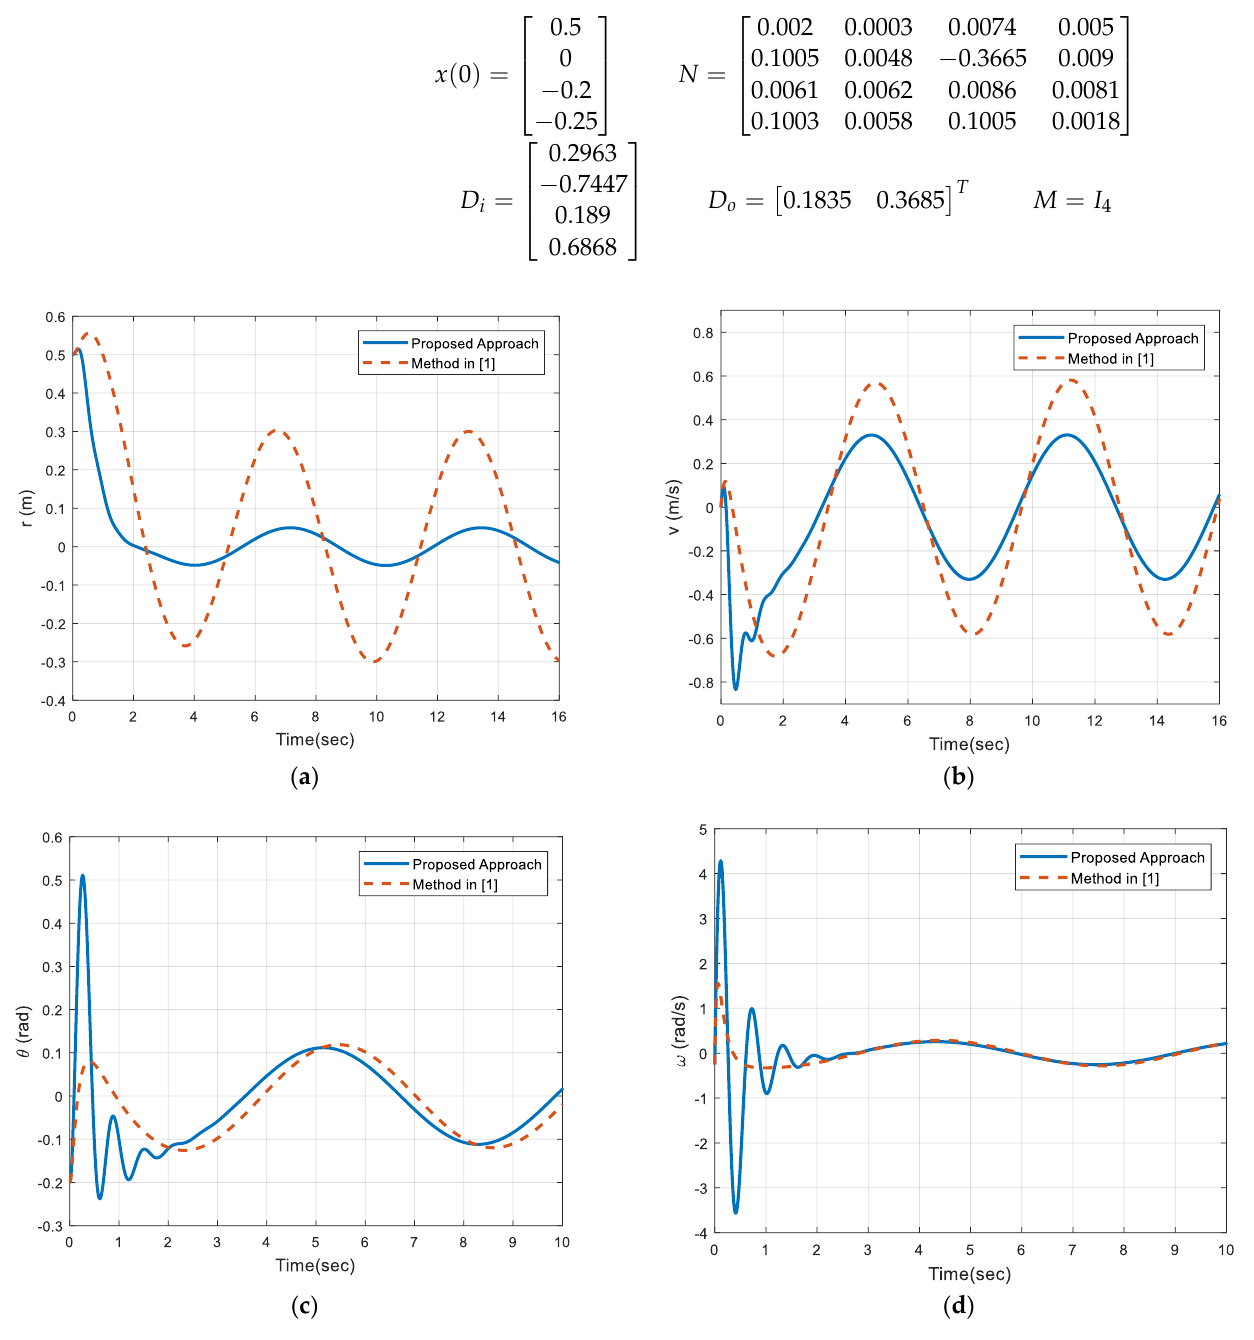
Figure 5. ( a ) State x 1 trajectory of a perturbed nominal nonlinear system (indicating the suggested approach’s stabilizing efficiency in comparison to the method of Golestani et al., 2020, applied in [1]). ( b ) State x 2 trajectory of a perturbed nominal nonlinear system (indicating the suggested approach’s stabilizing efficiency in comparison to the method of Golestani et al., 2020, applied in [1]). ( c ) State x 3 trajectory of a perturbed nominal nonlinear system (indicating the suggested approach’s stabilizing efficiency in comparison to the method of Golestani et al., 2020, applied in [1]). ( d ) State x 4 trajectory of a perturbed nominal nonlinear system (indicating the suggested approach’s stabilizing efficiency in comparison to the method of Golestani et al., 2020, applied in [1]).